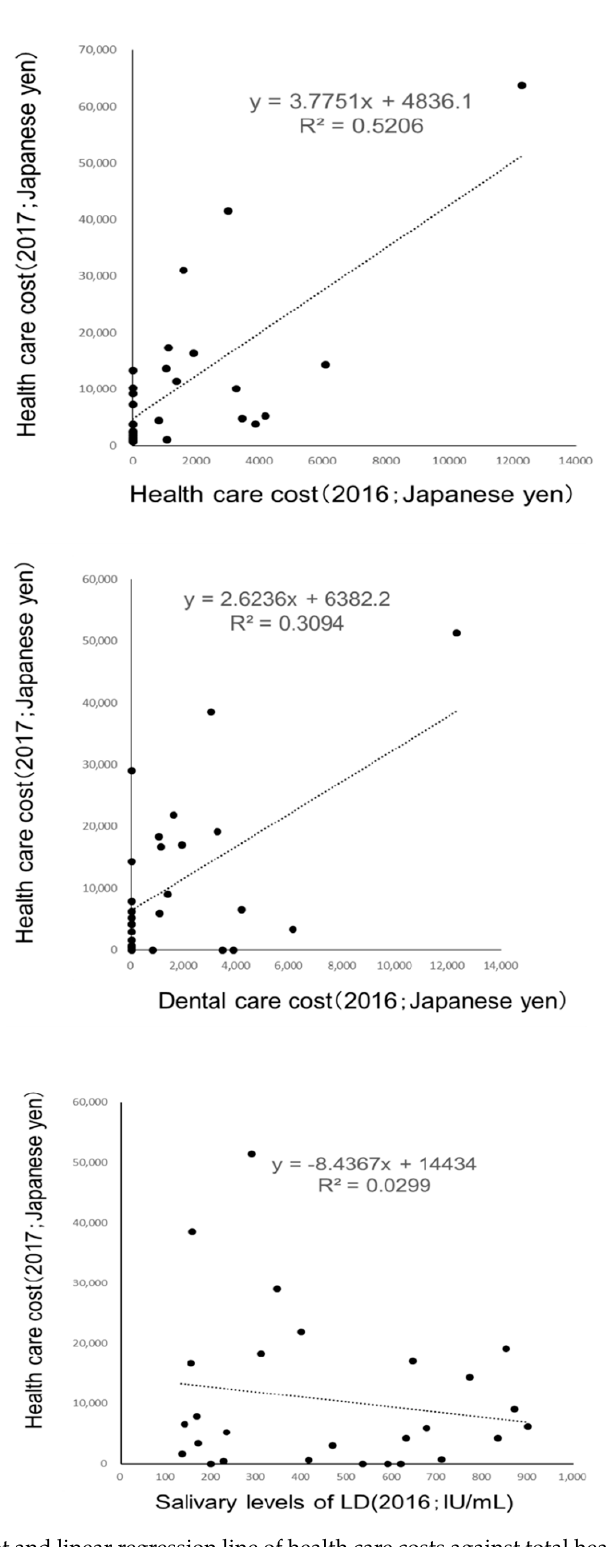
Figure 1. Scatter plot and linear regression line of health care costs against total health care costs, dental health care costs, and salivary levels of lactate dehydrogenase (LD). * The coefficient of determination (R 2 ) was not high. Health care costs were not easy to predict by linear regression analyses.